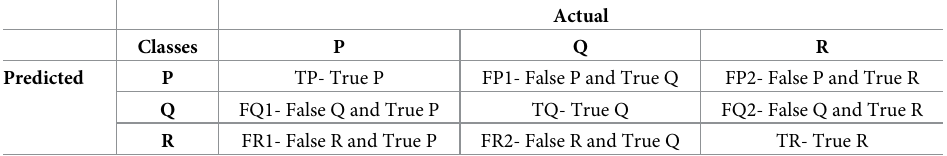
Table 5. Confusion matrix utilized in our study.